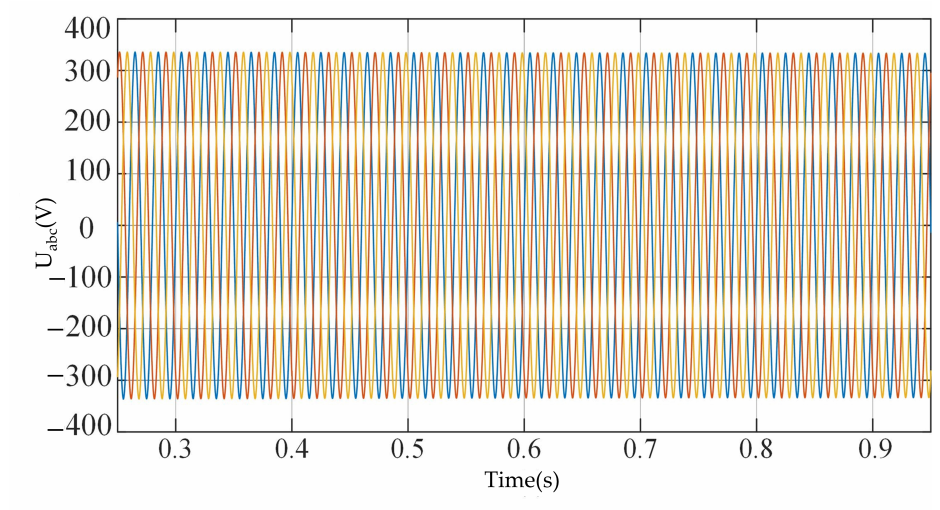
Figure 17. Three-phase voltage variation result during the transition process.